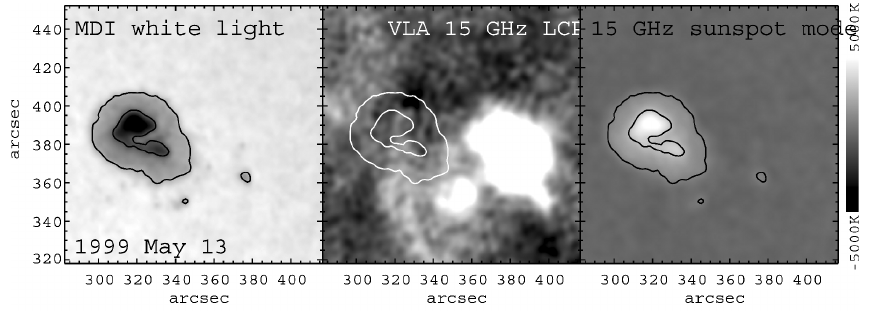
Fig. 1. The large sunspot in the AR 8535 on 1999 May 13: the SOHO MDI white light image (left panel); the VLA image of the intensity in left-hand circular polarization (o-mode in this case of positive magnetic polarity) at 15 GHz (middle panel); the image recalculated from the white light image (right panel). The brightness temperature range at 15 GHz is from –5000 to 5000 K relative to the quiet Sun level. This figure adopted from Loukitcheva, Solanki & White (2014) and reproduced with permission from Astronomy and Astrophysics, c (cid:13)